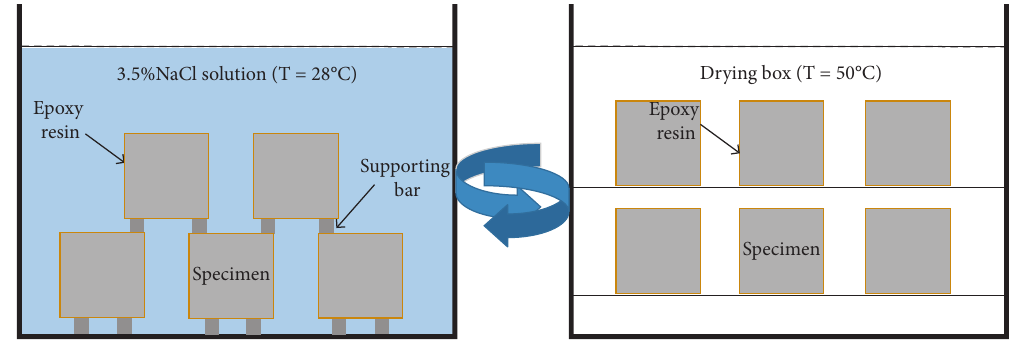
Figure 2: Schematic diagram of drying-wetting cycle